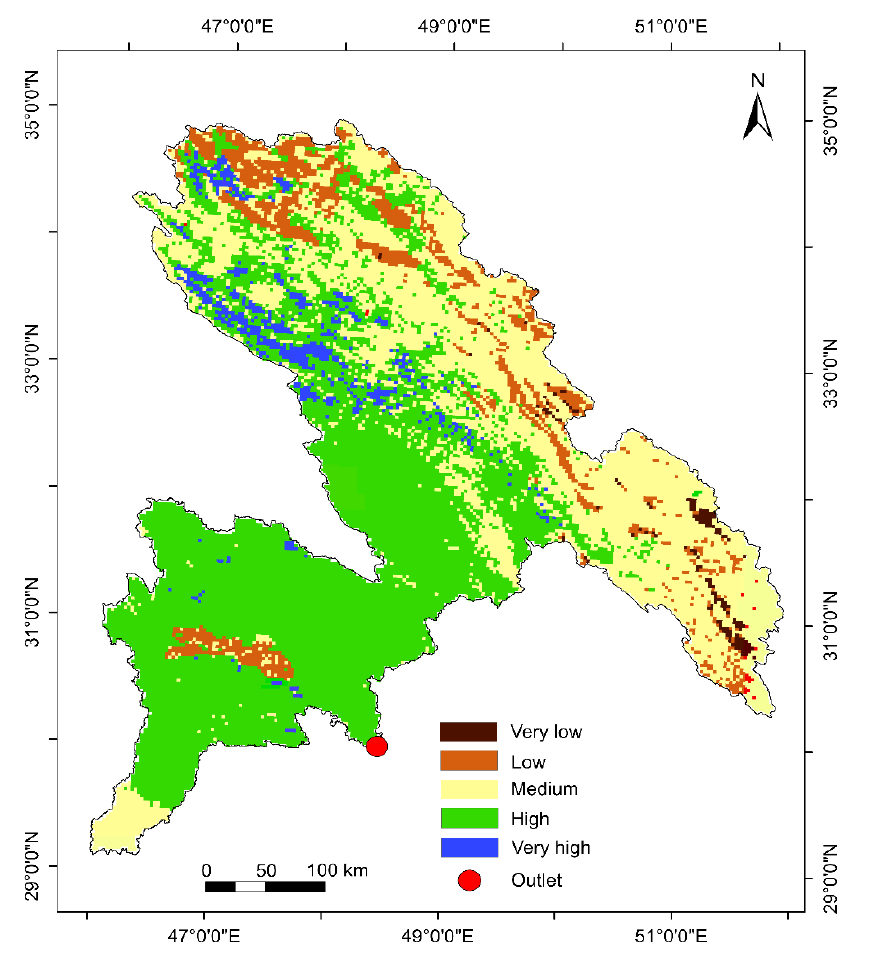
Figure 3. GWPZs of the study area.